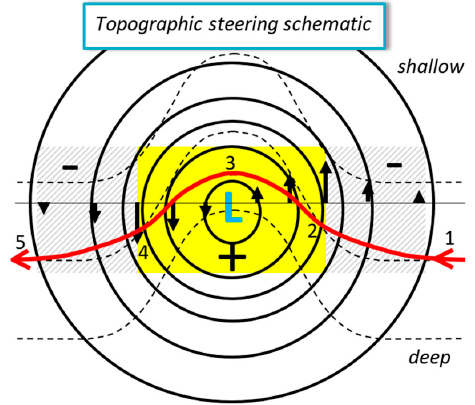
Figure 7. Schematic of topographic steering for right-bounded flow in the northern hemisphere. Dashed lines are topographic contours. Circles are contours of dynamic pressure anomalies. Arrows are flow anomalies. The symbol “+” marks zones of positive relative